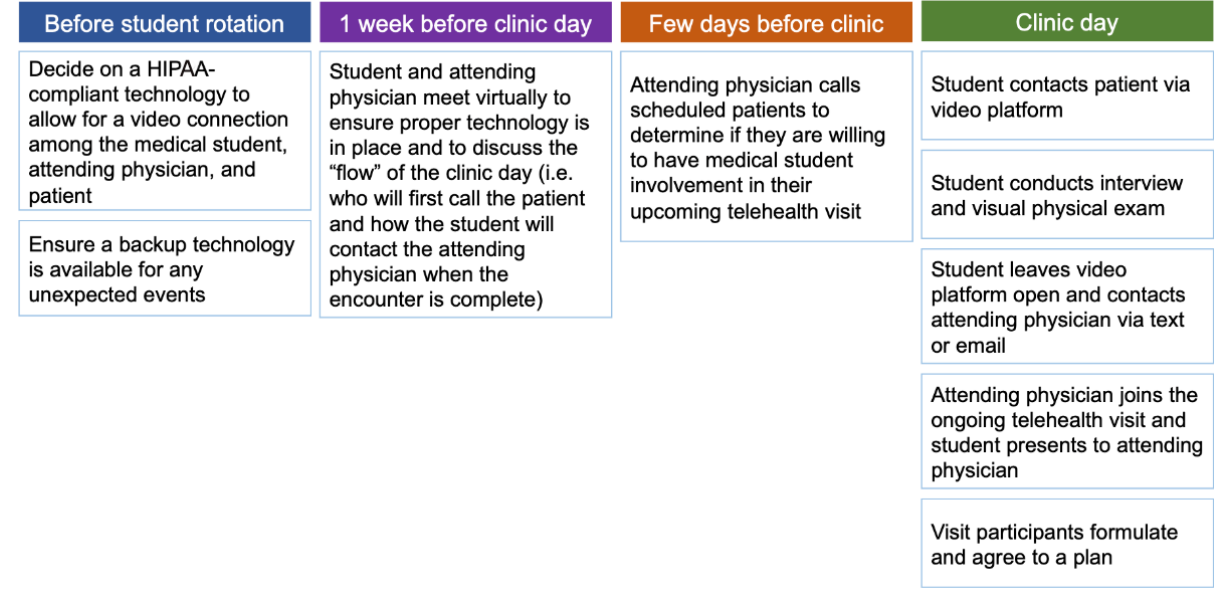
Figure 1. Flowchart of steps for including medical students in telehealth. The flowchart is organized by the time periods before a clinic day. HIPAA: Health Insurance Portability and Accountability